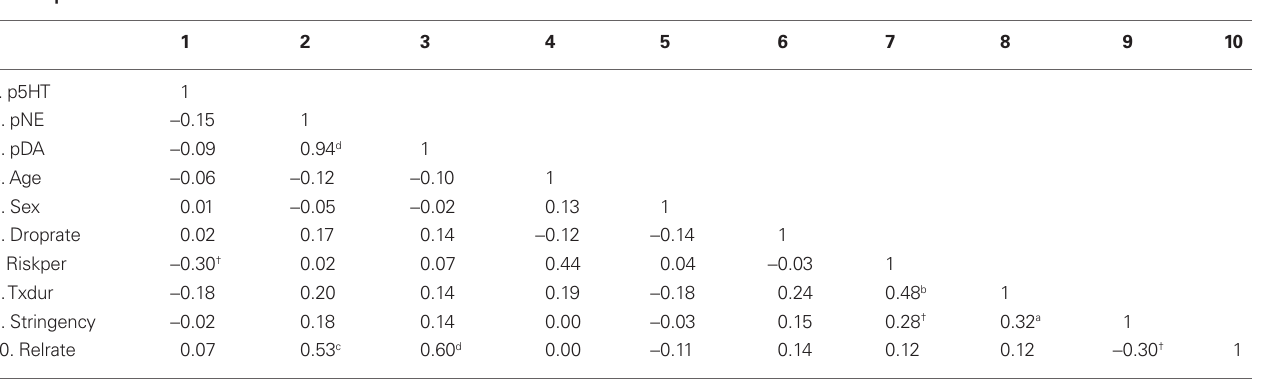
Table 4 | The bivariate correlations between the continuous and count